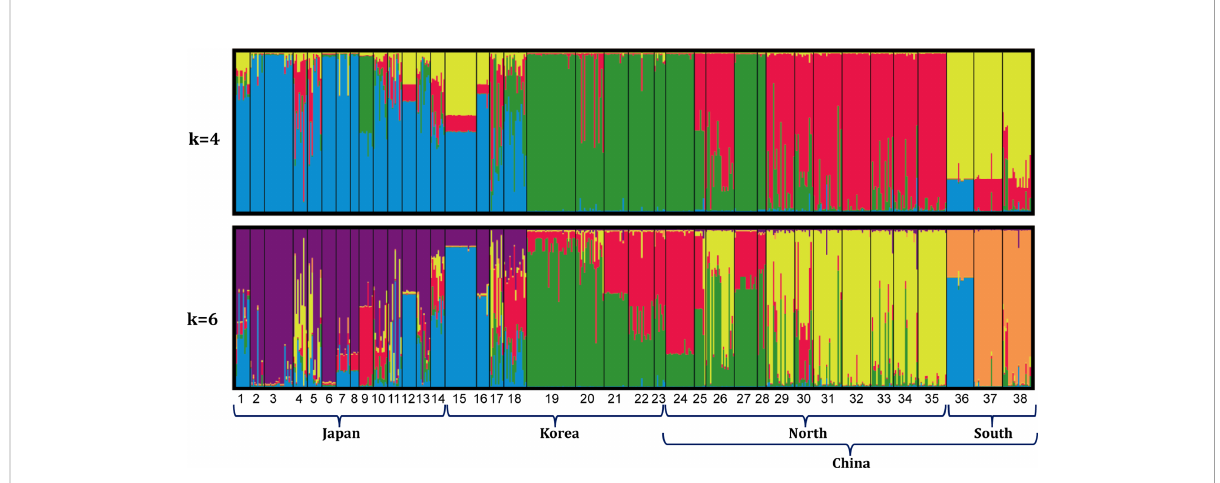
FIGURE 2 Genetic grouping of 38 G. vermiculophylla populations in the northwest Paci fi c based on STRUCTURE analysis (K = 4 and K =